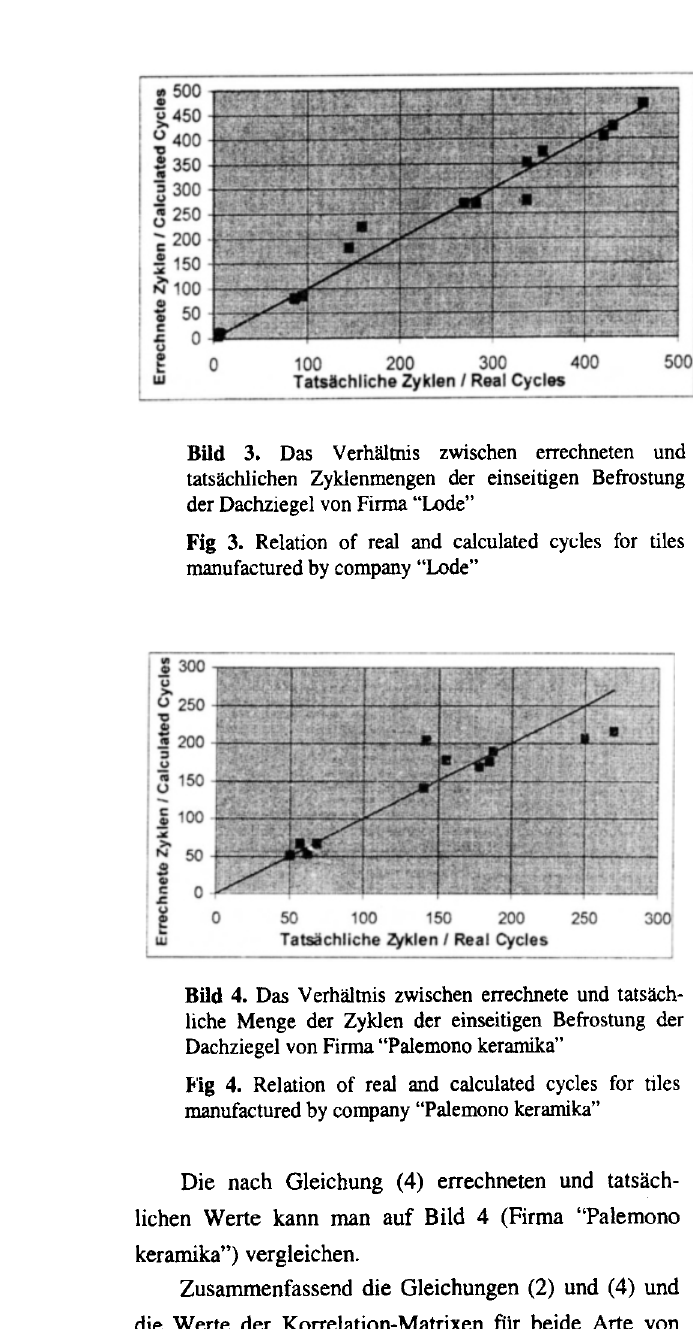
Fig S. Tile of company "Palemono kerarnika" destroyed in cycle 57, (see Table 3, sample 2). X axis: diameter of pores; Y(1) distribution of cumulative size of pores; Y(2) distribution frequency of pores according to